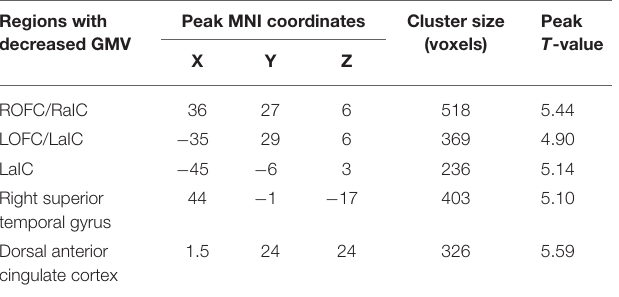
LaIC,leftanteriorinsularcortex;LOFC,leftorbitalfrontalcortex;RaIC,rightanteriorinsular cortex; ROFC, Right orbital frontal cortex.